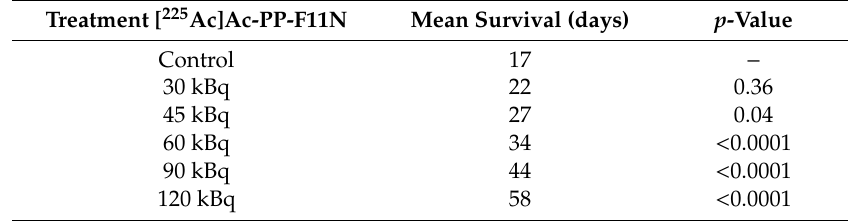
Table 1. Mean survival times of [ 225 Ac]Ac-PP-F11N-treated A431 / CCKBR tumor-bearing nude mice. Treatment [ 225